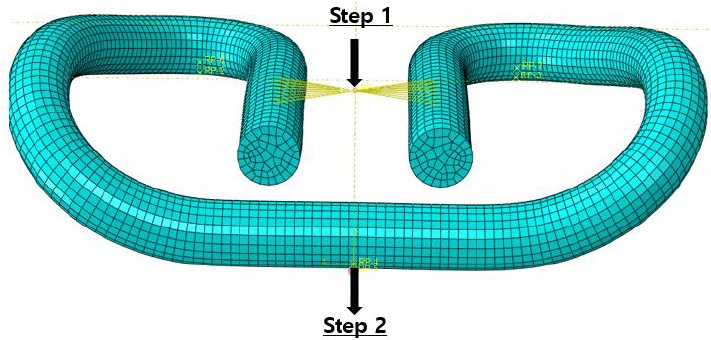
Figure 9. Loading steps of finite element analysis.